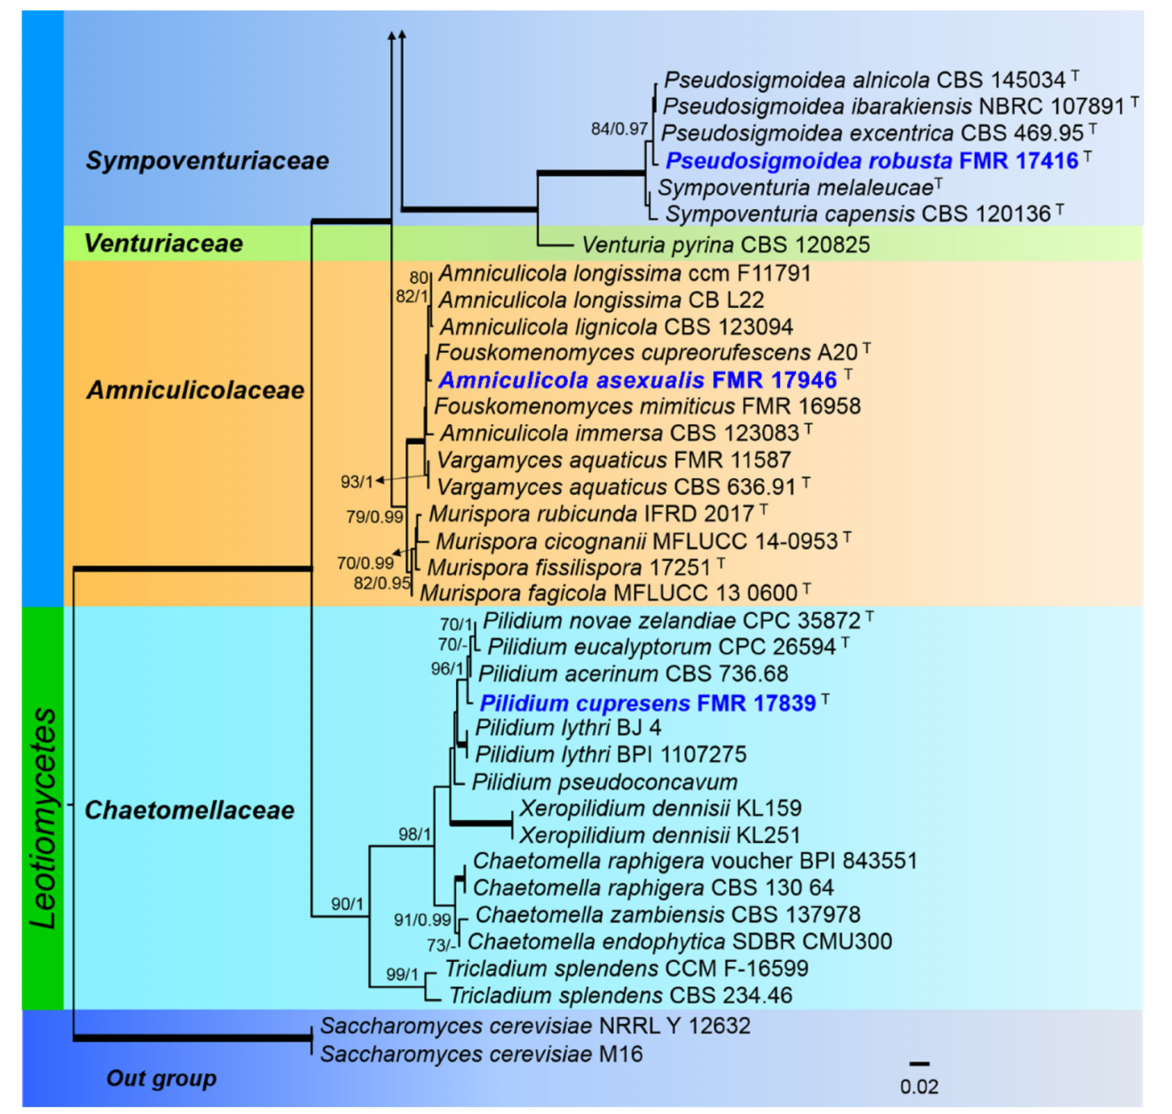
Figure 2. Phylogenetic tree inferred from an ML analysis of LSU nucleotide sequences of representatives of the Dothideomycetes and the Leotiomycetes classes. The RAxML bootstrap support values (BS) above 70% and the Bayesian posterior probabilities (PP) above 0.95 are given at the nodes (BS/PP). Fully supported branches (100 BS/1 PP) are indicated in thicker lines. Newly proposed taxa are given in blue . Type strains are indicated by a superscript “T”. The tree was rooted with Saccharomyces cerevisiae NRRL Y 12632 and M16. Alignment length 776